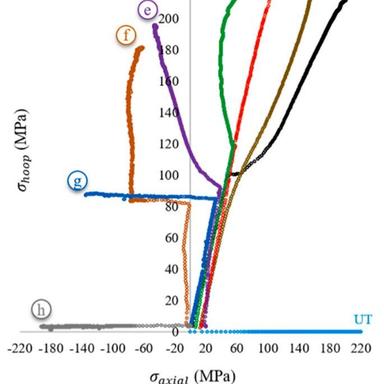
Stress paths for the nine deformation modes (one uniaxial and eight biaxial a-h).